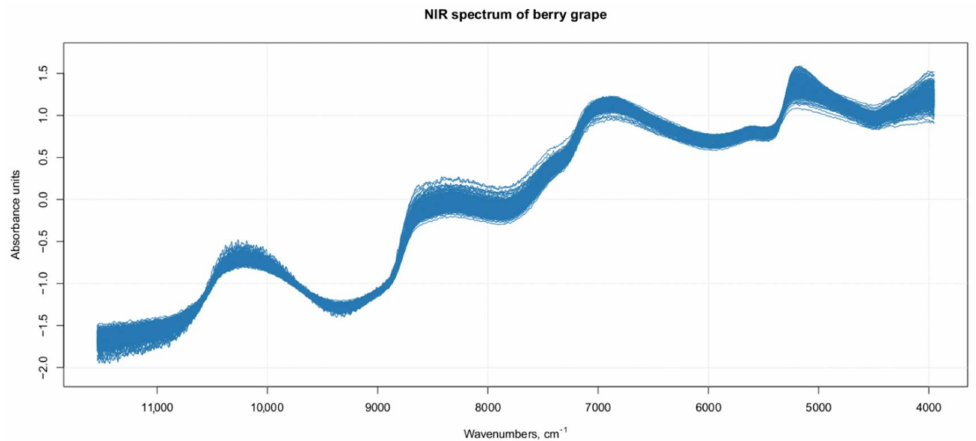
Figure 1. Spectra of single berries (each spectrum is a mean of three repetitions of different berry